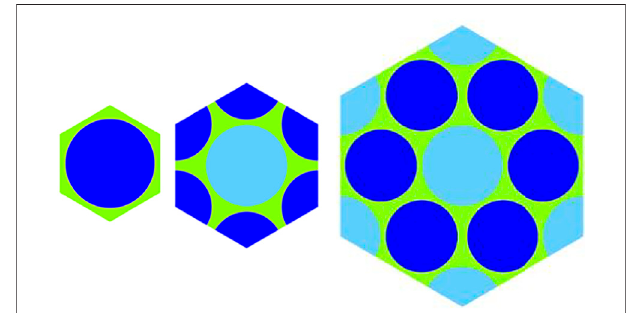
FIGURE 2 | The horizontal cross-section of the fuel pin, the unit cell, and the fuel assembly.